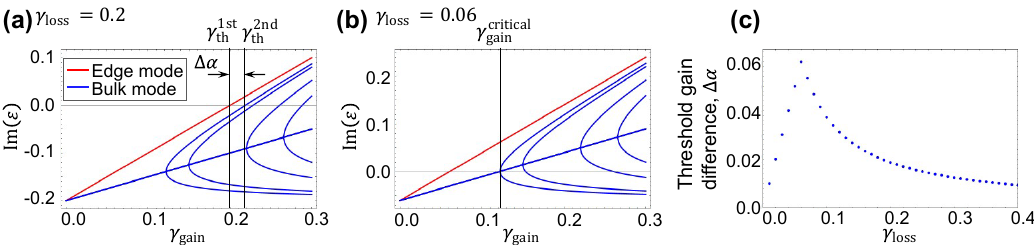
Figure 3: Threshold gain of the lasing modes. (a) and (b) Imaginary parts of eigenenergies of the system plotted as a function of supplied gain on A -site 𝛾 respectively. The red and blue lines indicate the energy of the edge mode and bulk modes. (c) Loss dependence of the threshold gain difference Δ 𝛼 . The parameters used are 𝜅 topological